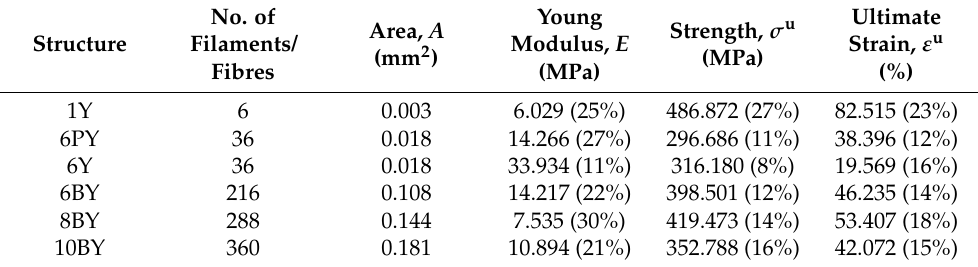
Figure 11. Average true stress–strain curves of the different PVA fibrous architectures. Table 2. Mean values obtained in tensile loading for analysed PVA structures. Values in parenthesis represent the coefficient of variation in percentage.